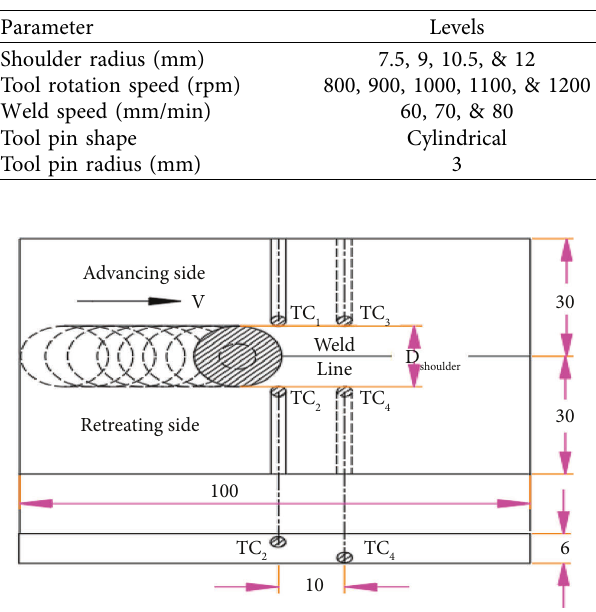
Figure 4: Experiment